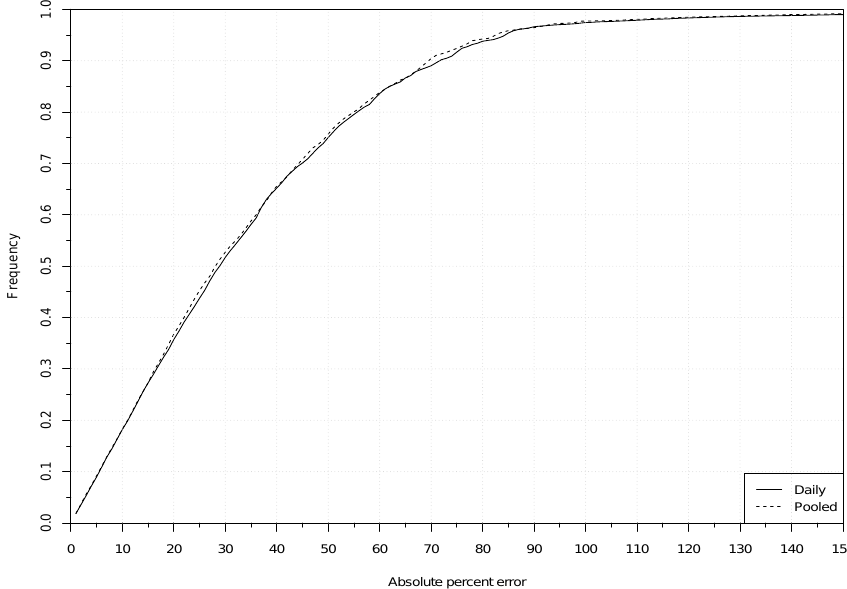
Figure 3. Median cumulative distribution of absolute percent errors in daily estimates for streamflow estimated from both daily and pooled variogram parameter